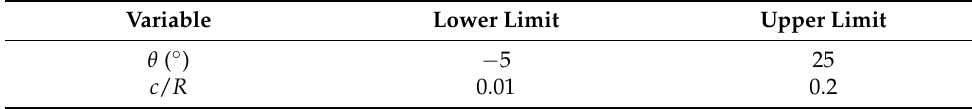
Table 1. The considered range for the design variables